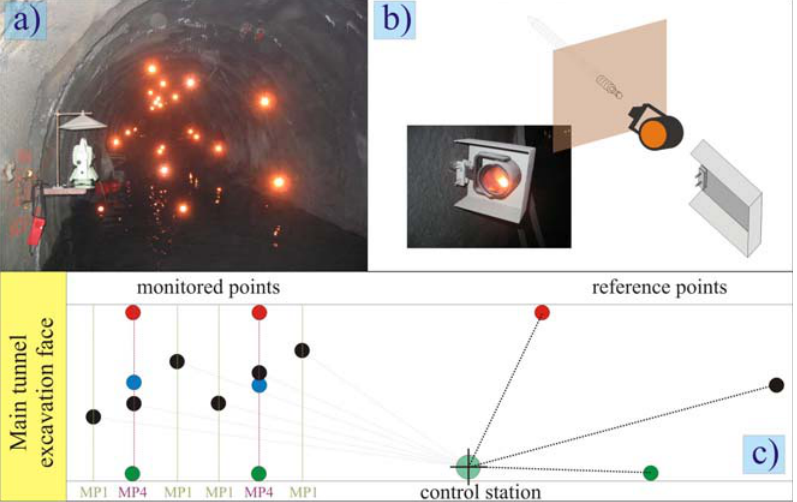
Figure 4. (a) Photo of the disposition of the reflectors in the exploratory tunnel. (b) Detail of the reflector and its protection. (c) Plan view of the monitoring